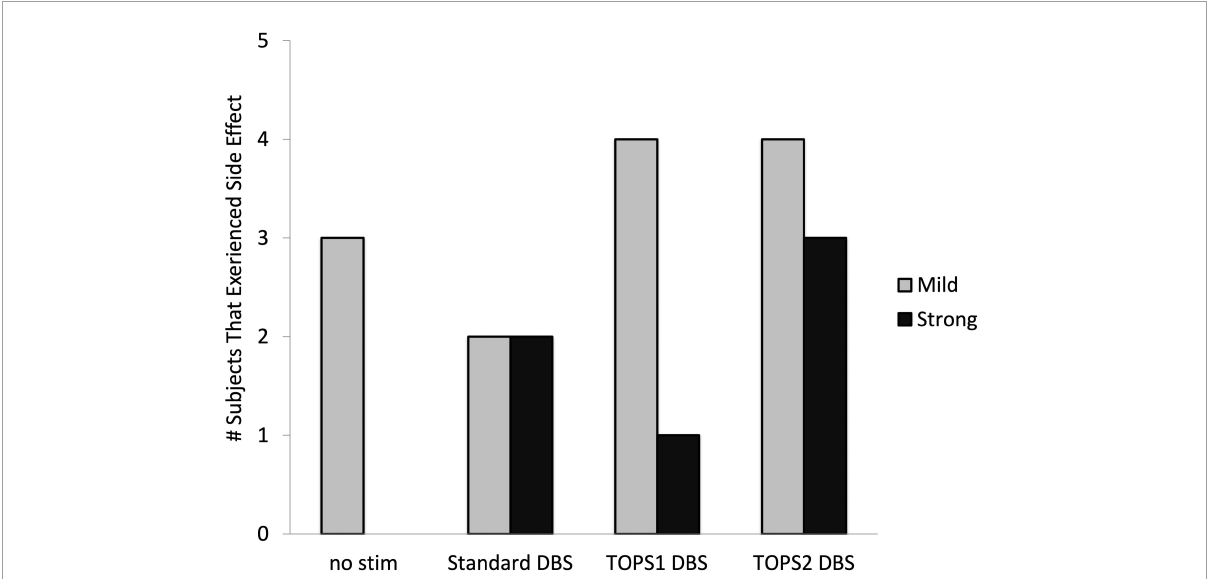
FIGURE5 Number of subjects who experienced side effects with each stimulation pattern. Side effects with a mild intensity were rated less than an eight. Side effects with strong, sustained intensity and considered intolerable were rated 8, 9, or 10. Side effects were assessed in n = 26 (no stim), n = 23 (sDBS), n = 24 (TOPS1), and n = 21 (TOPS2) out of 26 subjects.